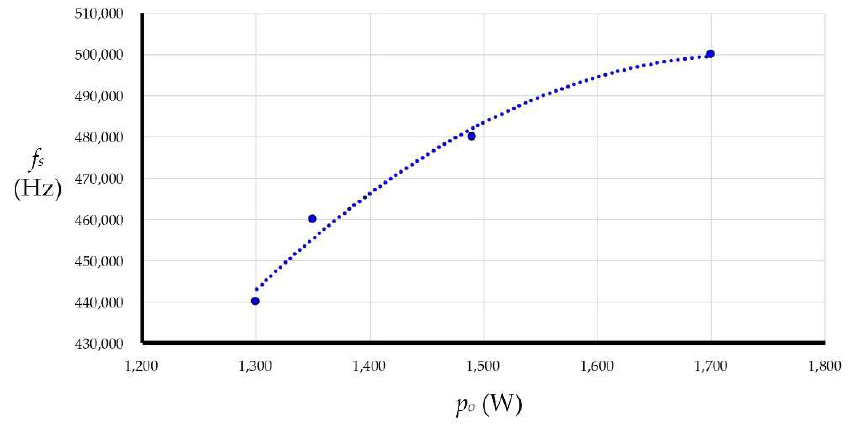
Figure 15. Relationship between the heating power and the operating frequency of the proposed induction heating system.